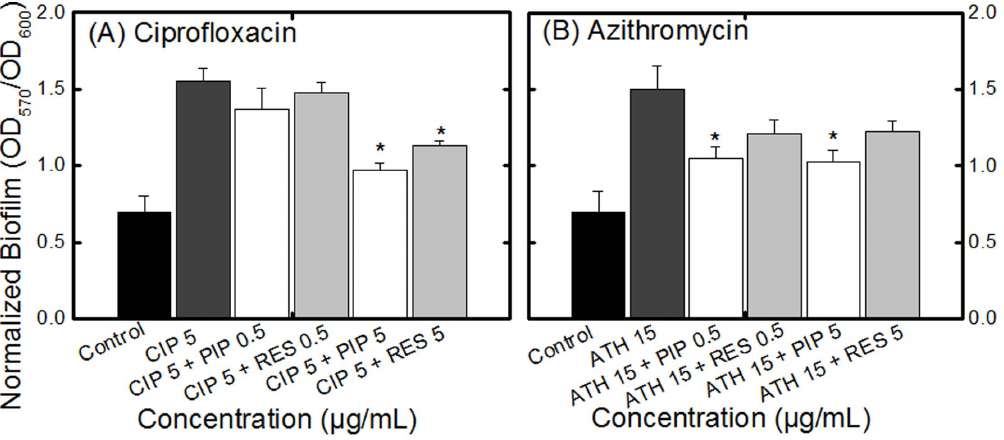
Figure 6. Effect of PIP and RES on the efficacy of antibiotics (A) ciprofloxacin (CIP 5 m g/mL) and (B) azithromycin (ATH 15 m g/mL) towards fully developed E.coli CFT073 biofilms. The biofilms were allowed to form for 48 h and were subsequently incubated with the alkaloids for 24 h. Control indicates biofilms not treated with antibiotic or alkaloids. All biofilm values (OD 570 ) are normalized with growth (OD 600 ). Values for OD 570 are presented in Figure S6. Abbreviations: PIP 0.5 or RES 0.5, piperine or reserpine at 0.5 m g/mL (e.g., PIP 0.5 indicates piperine at 0.5 m g/mL). * indicates statistically significant ( p , 0.05) decrease in biofilm level for alkaloid + antibiotic treatment compared to the respective antibiotic treatment (CIP 5 or ATH